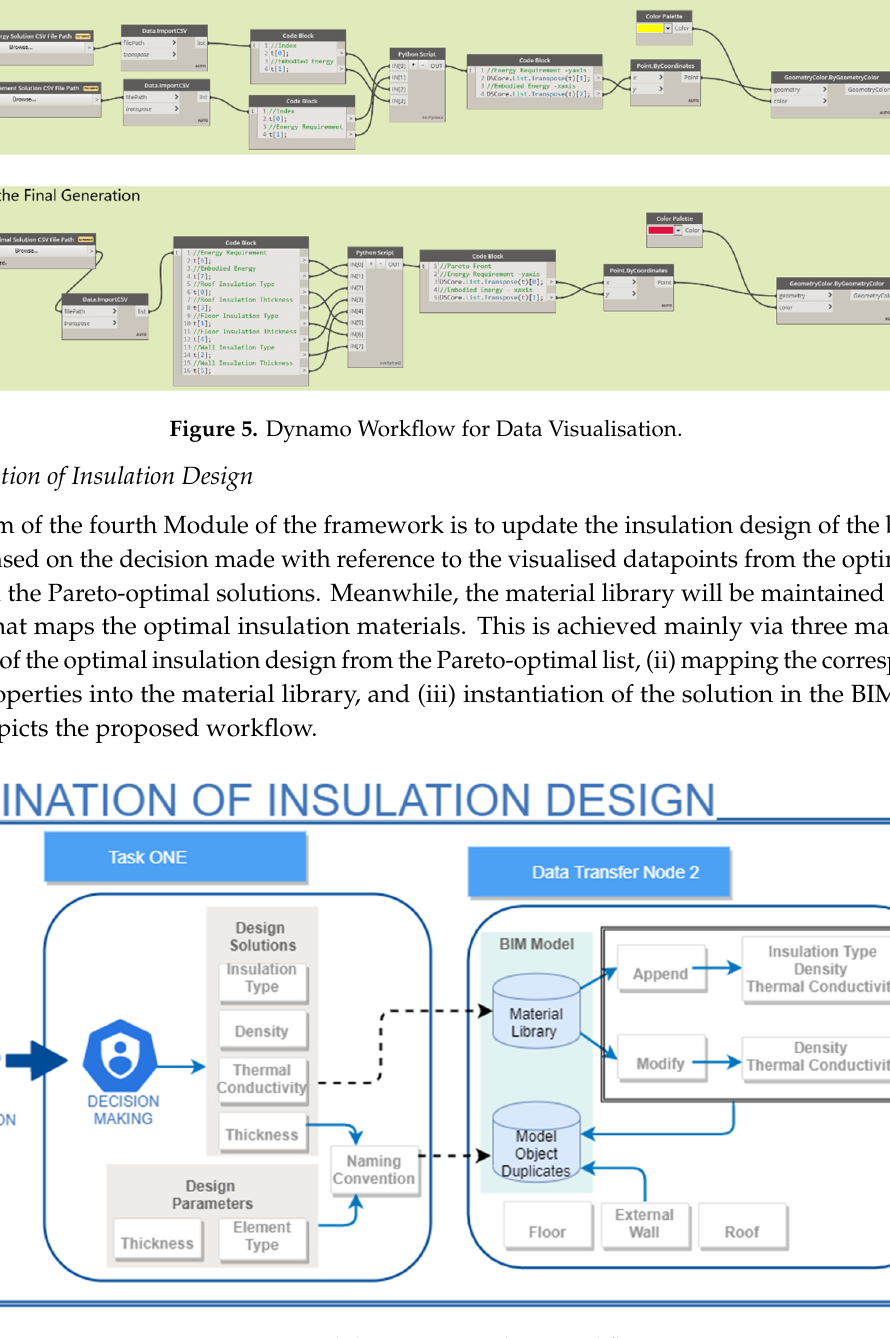
Figure 6. Module Decision-Making Workflow.